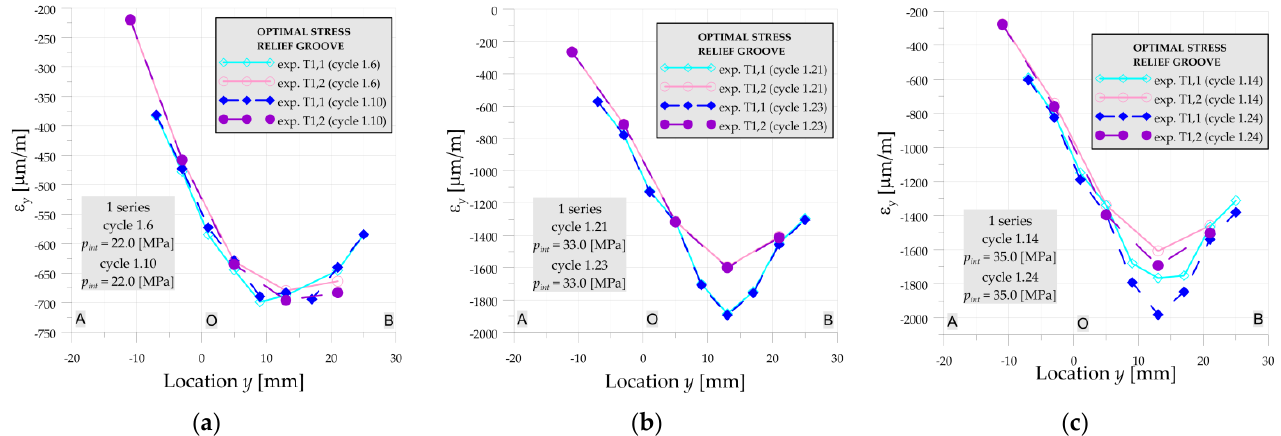
Figure A6. Repeatability of strain gauge measurements, optimal SRG, 1st series: ( a ) cycles 6 and 10; ( b ) cycles 21 and 23; ( c ) cycles 14 and 24.